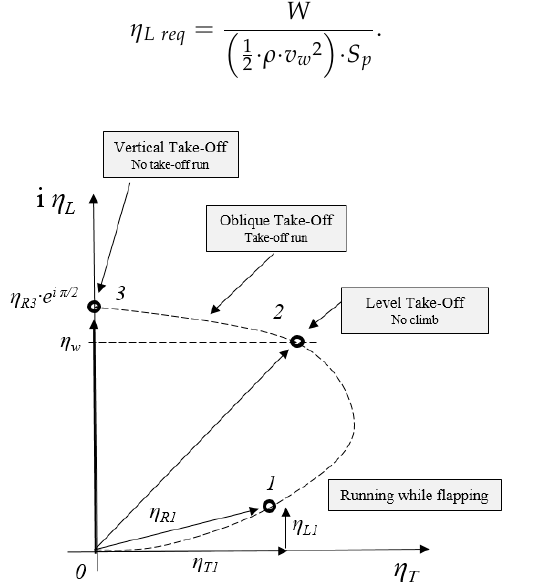
Figure 11. A hypothetical history polar showing the different performance capabilities of a bird and a protobird. a